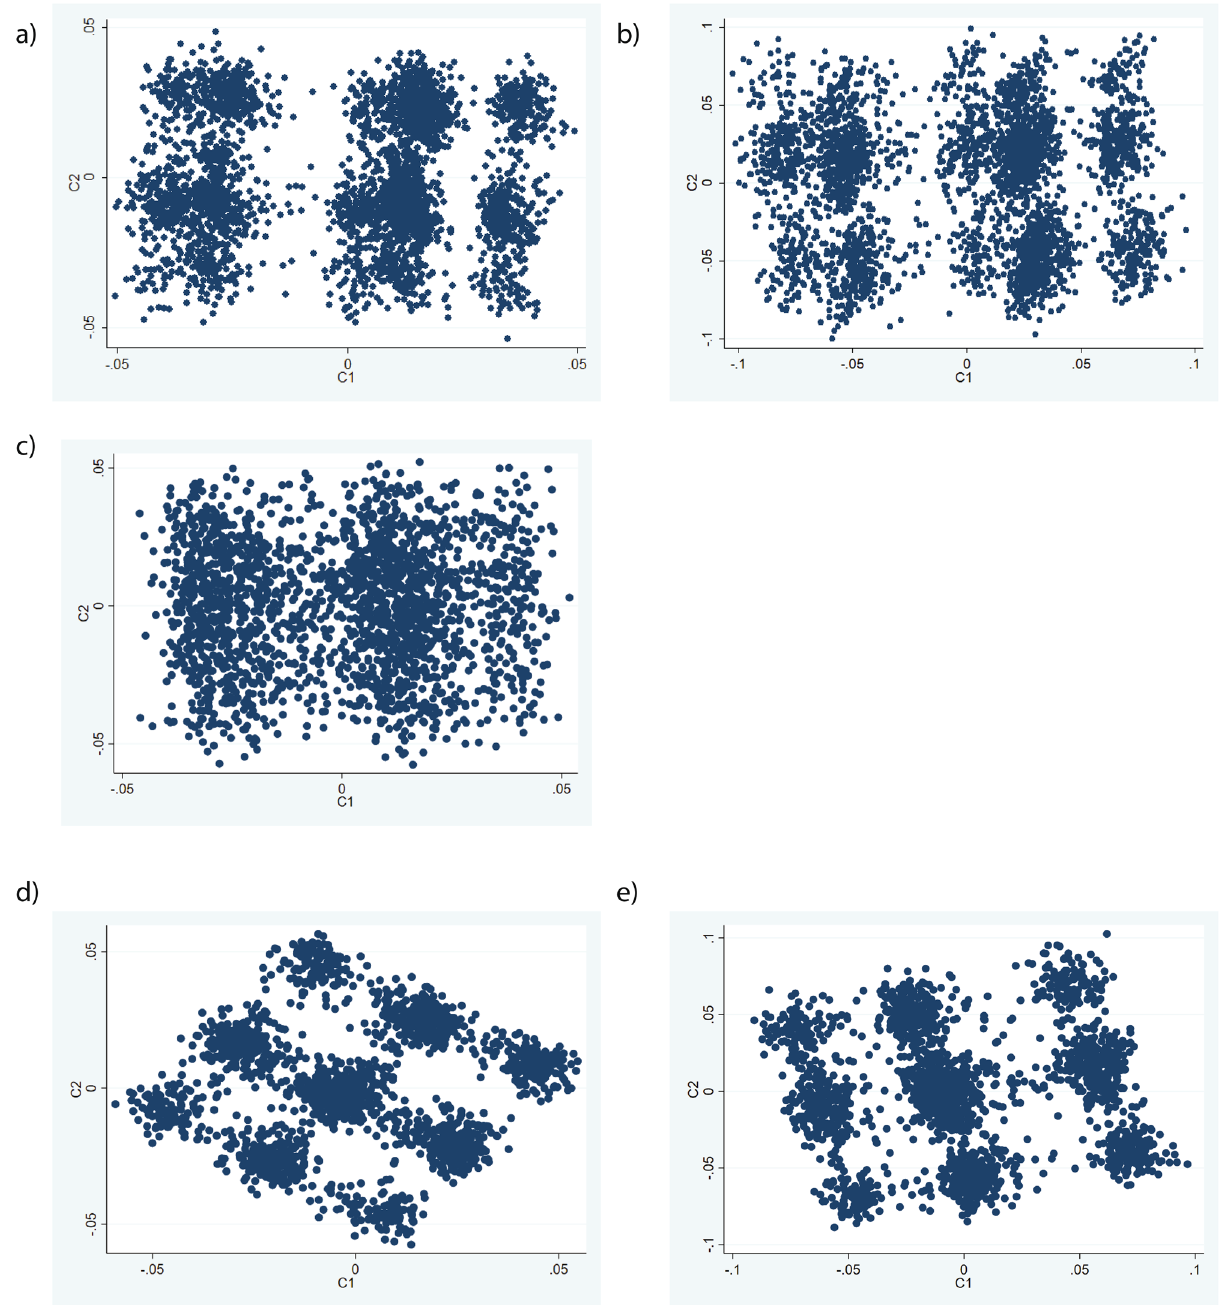
Figure 3. Sensitivity testing in UKB1. For comparison, IMPROVE MDS analysis using ( a ) MAF > 1% and ( b ) MAF > 10%. MDS analysis in UKB1 using ( c ) the same post-filtering SNPs as for IMPROVE, ( d ) the same pre-filtering SNPs with MAF > 1% in UKB1 and ( e ) the same pre-filtering SNPs with MAF > 10% in UKB1. Each data point is an individual therefore the individuals who are closer together are more genetically